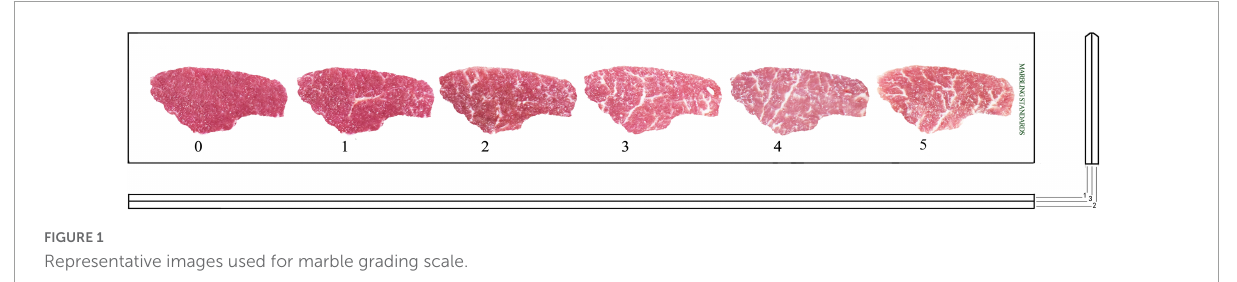
FIGURE1 Representative images used for marble grading scale.